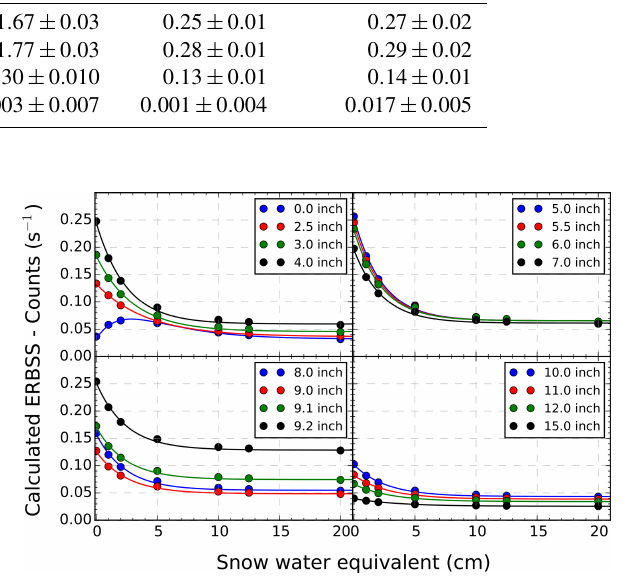
Figure 6. Count rates calculated for a solar modulation of 420MV, for the 3 He proportional counters of the used extended-range Bon- ner sphere spectrometer (ERBSS), based on simulated Geant4 neu- tron flux spectra and response functions of the ERBSS. Solid lines are the fit of the data points to ae − bx + c or axe − bx + c for the bare detector. Table 3. Fit parameters of the fitted functions ( ae − bx + c or axe − bx + c for the bare detector) shown as solid lines in Fig. 6.